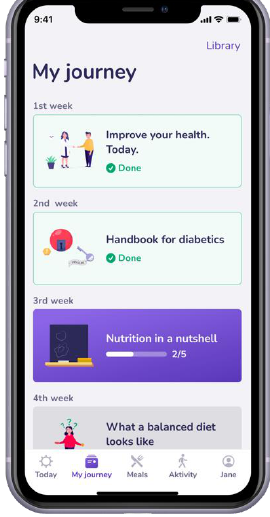
Figure A1. Interactive education in the app.